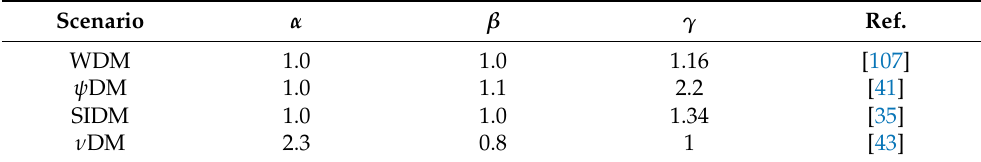
Table 1. Parameters describing the ratio of the halo mass function for different DM scenarios relative to the standard CDM in terms of the expression [ 1 + ( α M cut / M H ) β ] − γ , where M H is the halo mass H and M cut is a characteristic cutoff scale, see Section 2.2 for details. The values of the parameters H ( α , β , γ ) , extracted from fits to the outcomes of numerical simulations in the considered DM scenarios, are taken from the literature studies referenced in the last column. Scenario α β γ Ref. WDM 1.0 1.0 1.16 [107] ψ DM 1.0 1.1 SIDM